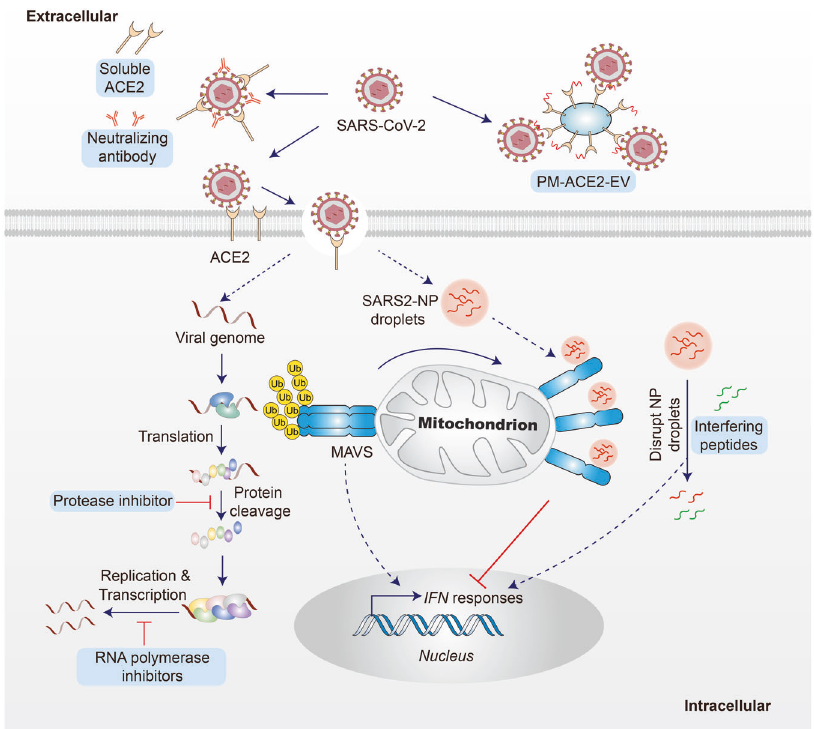
Fig. 4 Mechanisms of antiviral drugs and potential treatments against SARS-CoV-2 Omicron. Extracellularly, soluble ACE2, neutralizing antibodies, and palmitoylated ACE2-enriched EVs can capture SARS-CoV-2 viruses and inhibit SARS-CoV-2 interaction with cell-surface ACE2, resulting in reduced infection. Intracellularly, on the one hand, the released viral genome is translated to produce the polyproteins, which are cleaved by proteases to yield the RNA replicase – transcriptase complex. Then viral genome is duplicated and mRNA encoding structural proteins are transcribed. The protease inhibitors and RNA polymerase inhibitors can be used to inhibit the process of cleavage, transcription, and replication. On the other hand, the N protein of SARS-CoV-2 undergoes LLPS with RNA, which inhibits the aggregation and Lys-63-linked poly-ubiquitination of MAVS and thereby suppresses the innate antiviral immune response. The usage of interfering peptides disrupting N protein droplets can restore the impaired immune